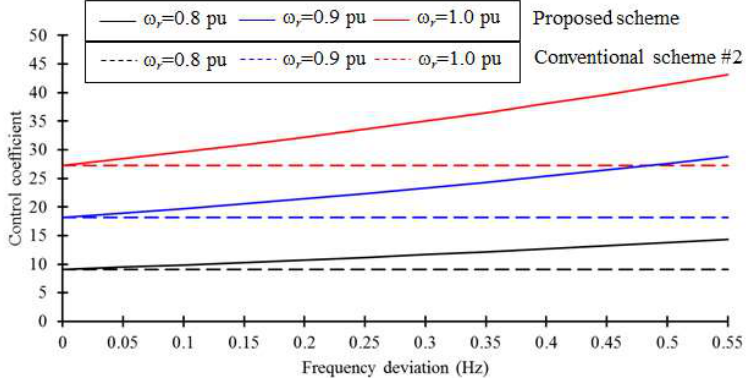
Figure 8. K sup for the proposed IRI scheme during the IRI period.